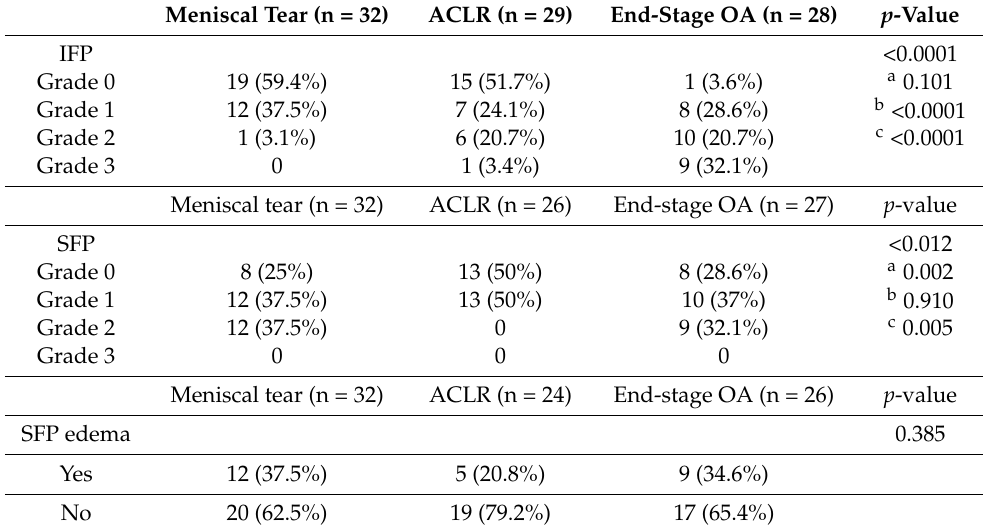
Table 3. IFP and SFP MR hypointense signal grading in meniscal tear, ACLR, and end-stage OA